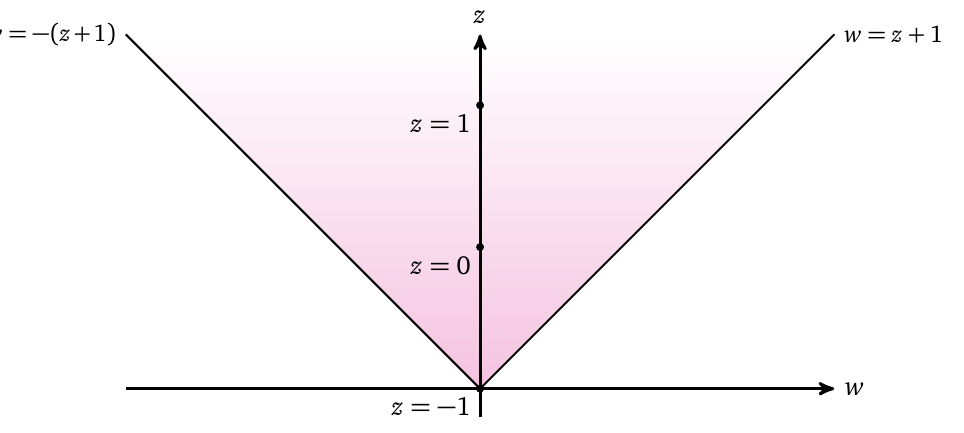
Figure 2: Solutions with horizon are in colored domain of ( w , z ) -parameter